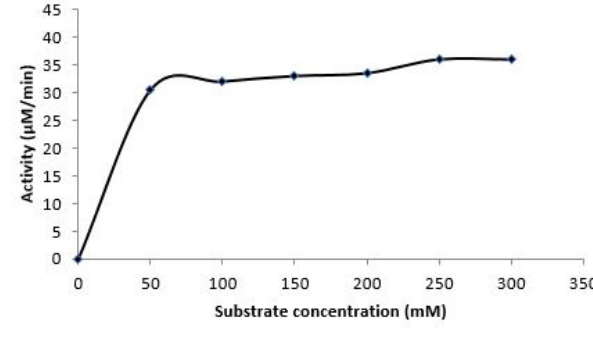
Figure 2: Concentration dependent effect of sucrose (substrate) on C. lanatus rind invertase activity.